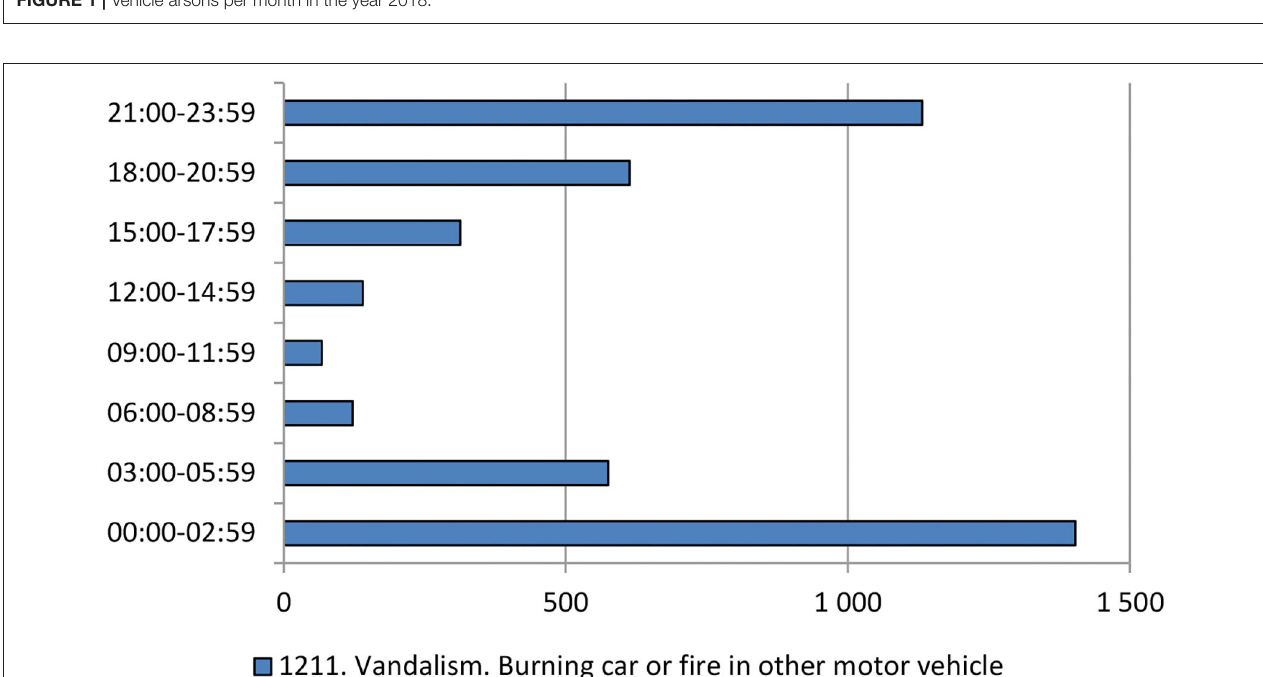
FIGURE 2 | Time of day for crime code 1211, vandalism through arson on a motor vehicle.